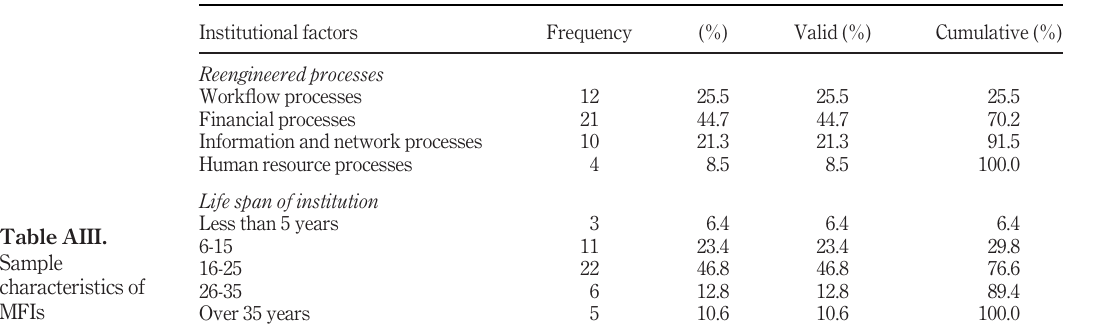
characteristics of MFIs